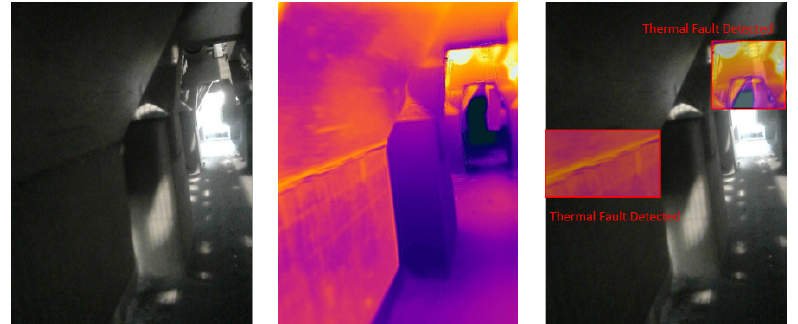
Figure 25. Thermal anomalies detection on-site for test run